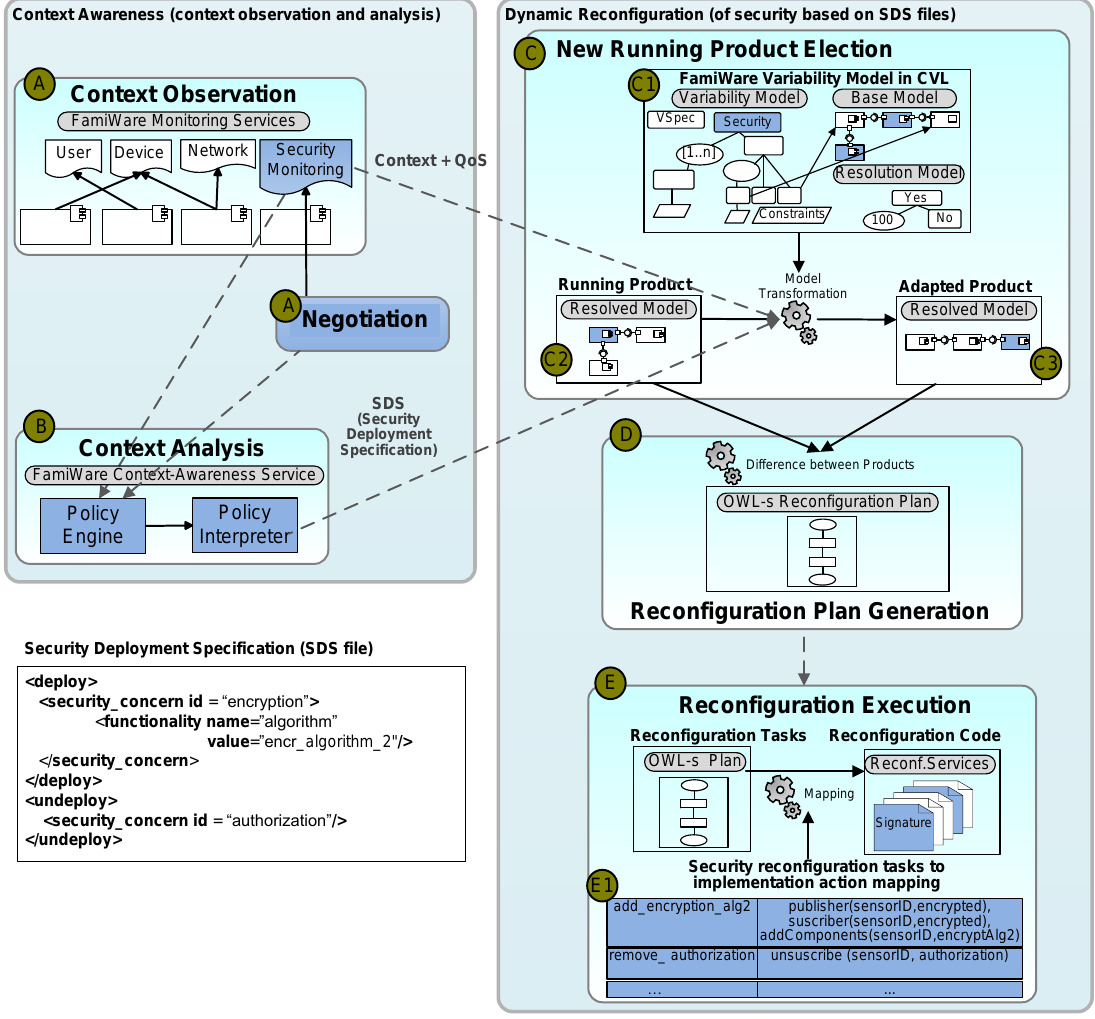
Figure 9. FamiWare runtime reconfiguration of